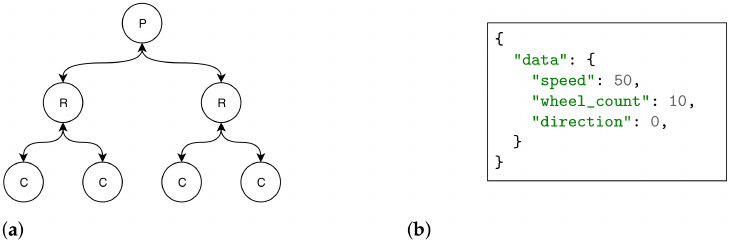
Figure 7. Simulation details: ( a ) Simulation topology (depth = 3); ( b ) JSON Train Data content. Table 1. Simulation set-up